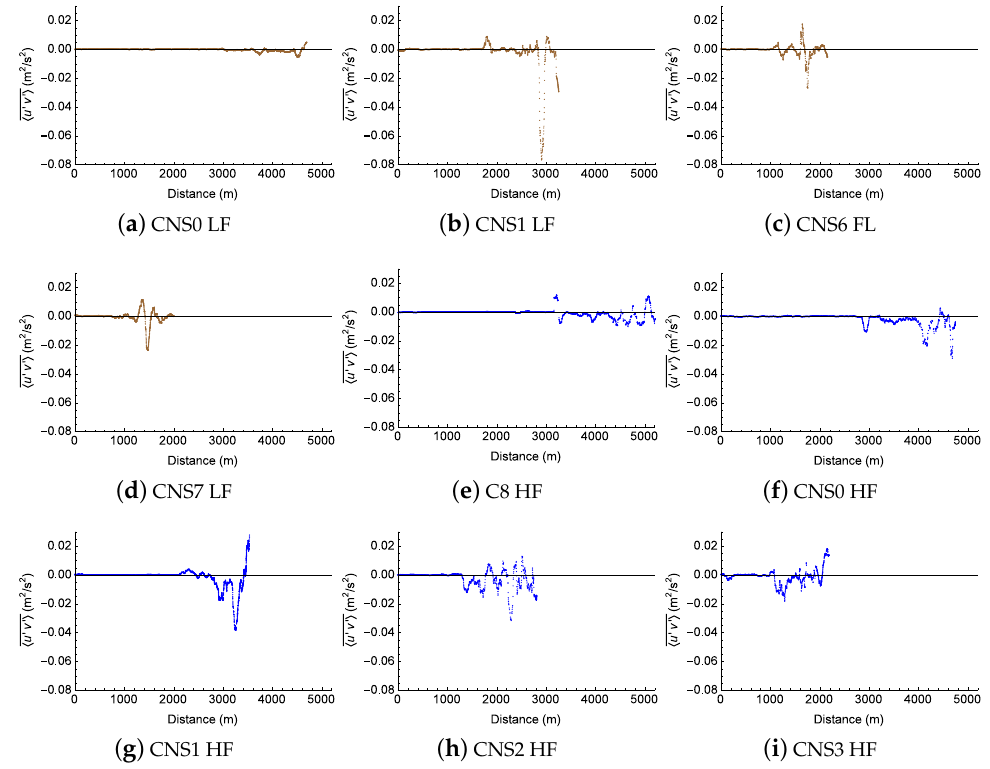
Figure 6. Profiles of the momentum flux by turbulence (cid:104) u (cid:48) v (cid:48) (cid:105) across the sampling transects. The brown and blue plots correspond to relatively low and high flow conditions,